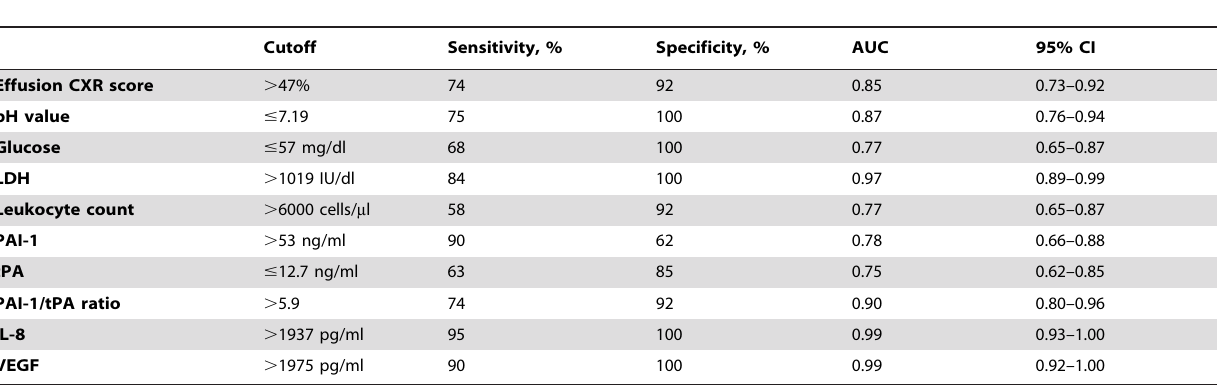
Table 3. Optimal Sensitivity, Specificity and Cutoff Value of Pleural Effusion Size and Variables for the Diagnosis of Complicated Parapneumonic